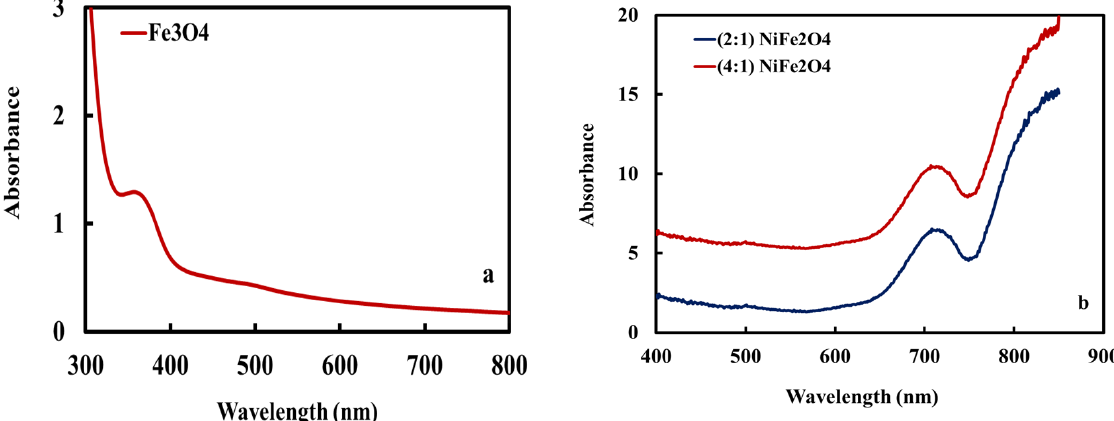
Figure 3. Representative ( a – c ) FESEM images at different magnifications and ( d ) EDS spectrum of the synthesized spinel (4:1) NiFe 2 O 4 MNPs.